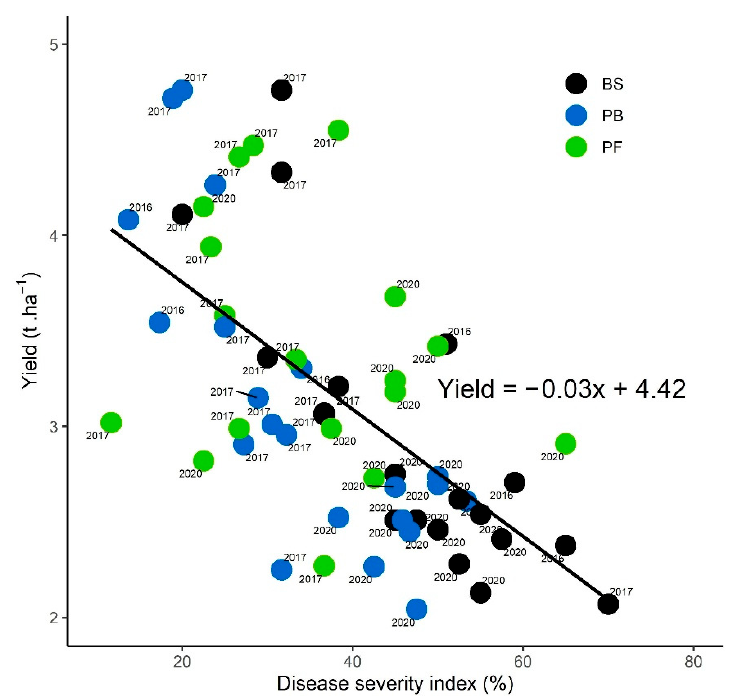
Figure 8. Causal relationship between manual sunflower yield (t ha − 1 ) and disease severity index (%) at sunflower maturity, for sunflowers cultivated after bare soil (BS), Brassicaceae (B) sole crops pooled per year, and Fabaceae (F) sole crops in 2016, 2017 and 2020. Each point represents the values (per blocks and plots) of the yield and the DSI of the cover crop composition per year. Data in 2019 and a mixture of two or three species in 2020 were removed from this regression because no significant regulation of SVW was observed.